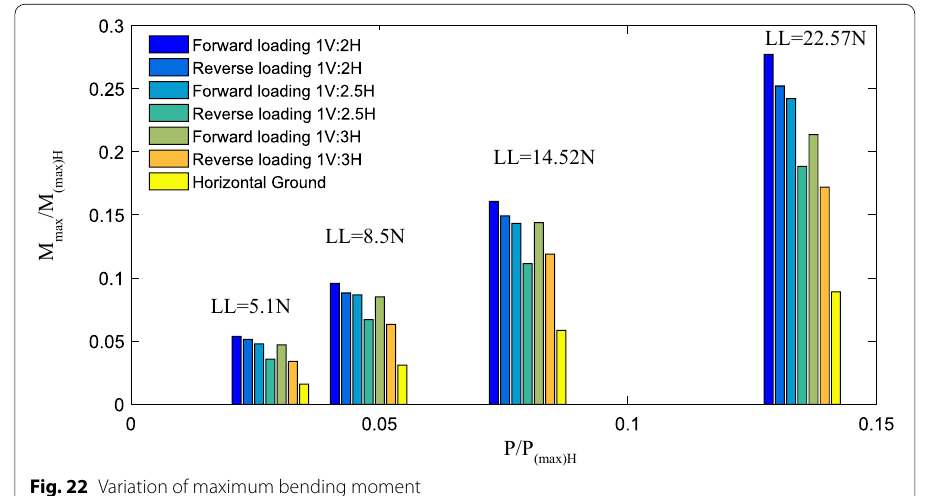
Fig. 22 Variation of maximum bending